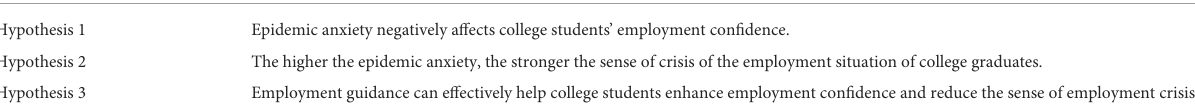
TABLE 1 Theoretical research